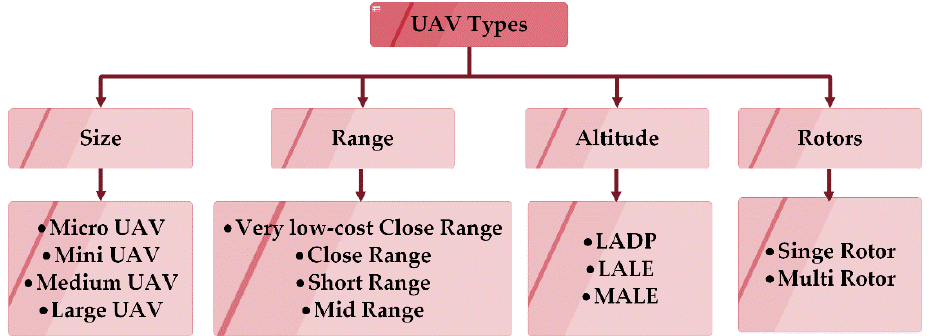
Figure 1. Classifications of Unmanned Aerial Vehicle types drones based on size, range, number of rotors, and altitude.